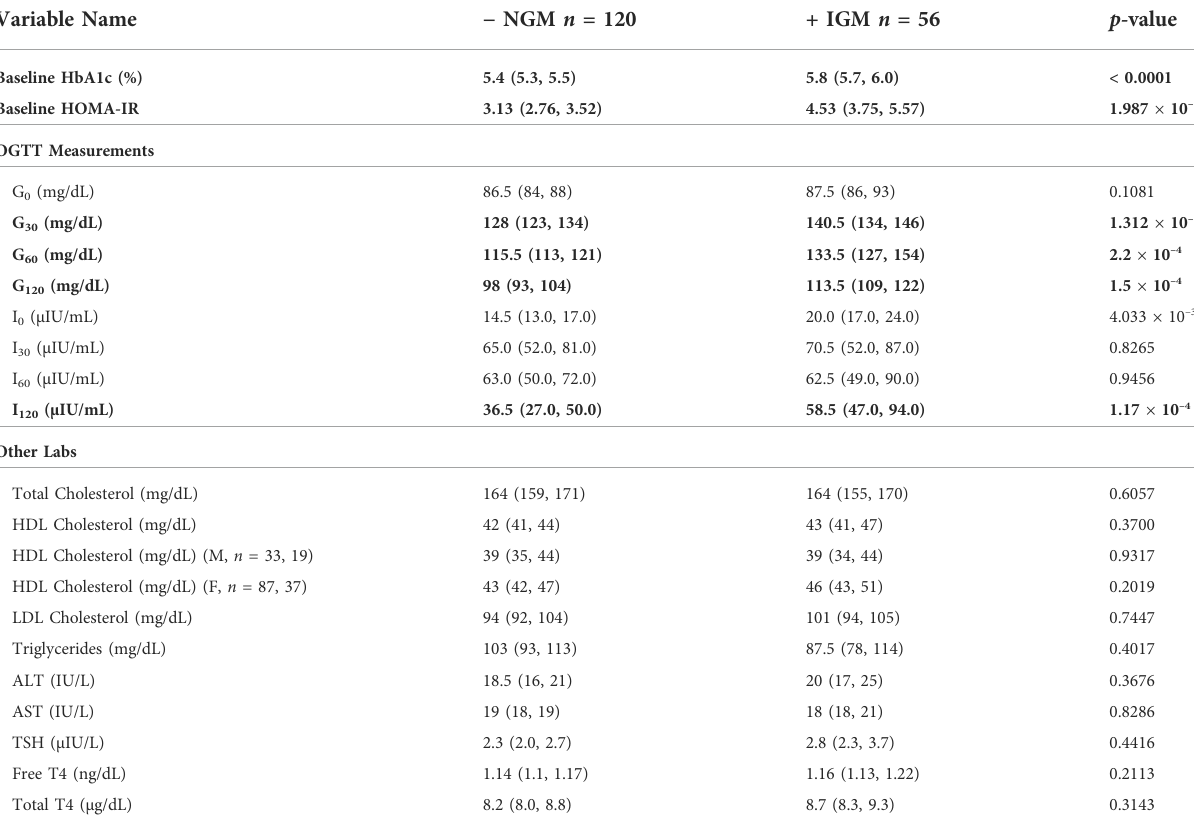
TABLE 3 Pre-operative laboratory value comparisons by binary post-operative outcome at 12 months. Medians with their 95% CI are shown. Signi fi cant p -values for Mann-Whitney-U tests after Bonferroni correction are in bold ( p < 0.002).